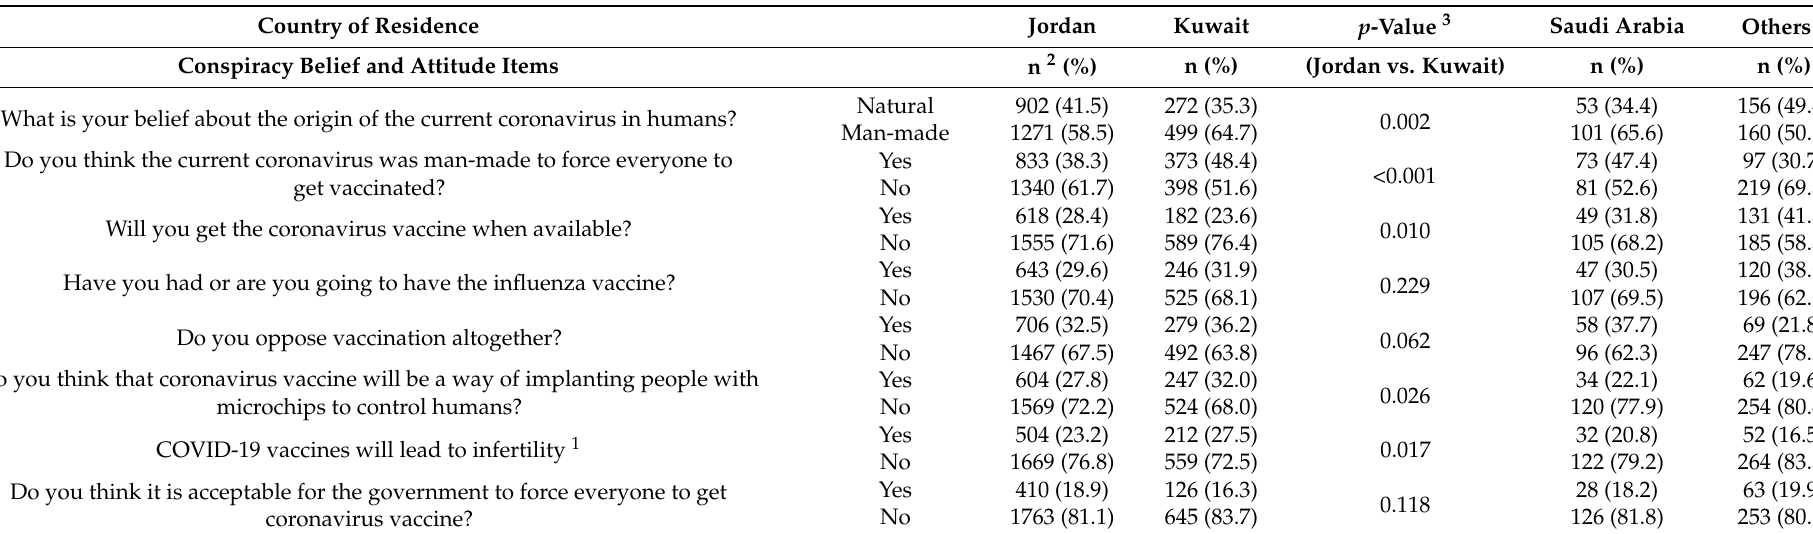
Table 3. Vaccine conspiracy beliefs and attitude items stratified by countries of